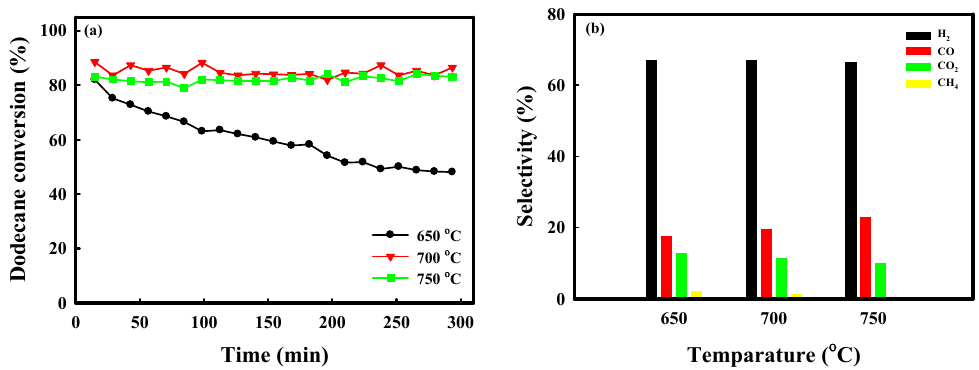
Figure 4. ( a ) Dodecane conversion and ( b ) initial selectivity of H 2 -reduced and NA10-PM at various temperatures (650, 700, and 750 °C) under S/C =1.23 and O 2 /C = 0.25.